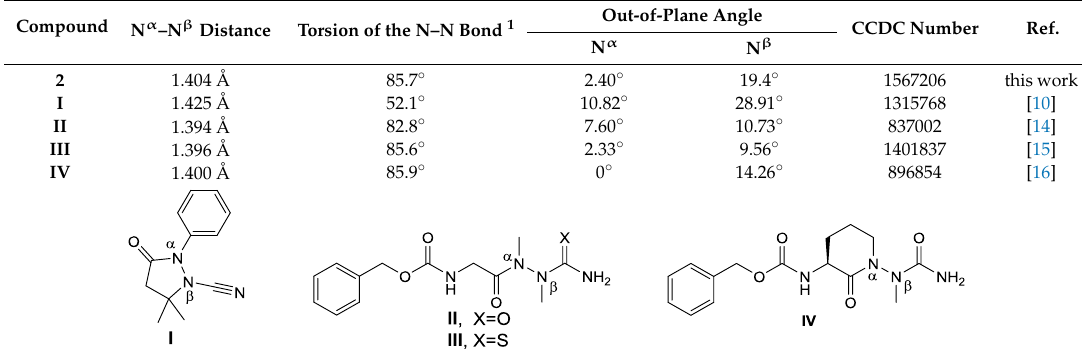
Table 3. Selected structural data of Compound 2 and comparison with cyclic cyanohydrazide I and related azapeptidic N , N ’-dialkylated (thio)semicarbazides II – IV . Compound N α –N β Distance